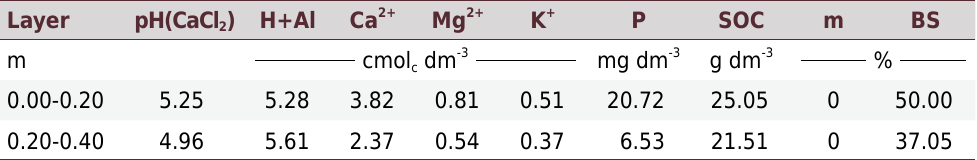
Table 1. Chemical properties of the Oxisol ( Latossolo Vermelho distroférrico ) before the experiment implementation Layer pH(CaCl 2 ) H+Al Ca 2+ Mg 2+ K + P SOC BS m